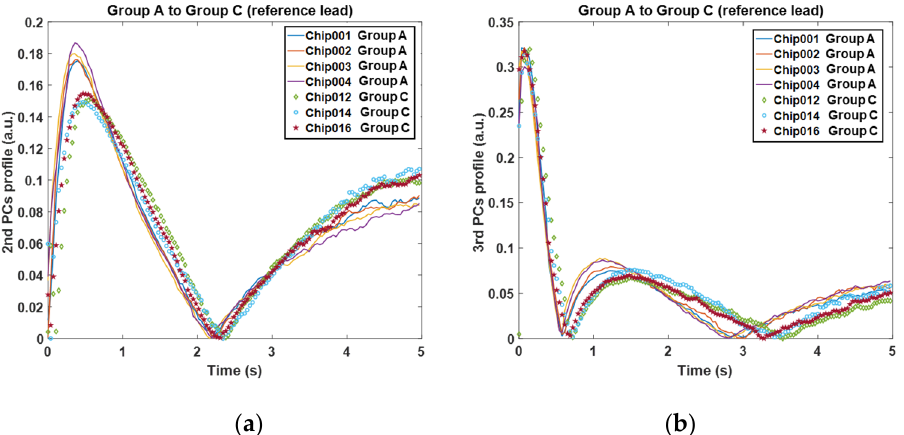
Figure 12. Feature results of the 1st verification comparison; ( a ) the 2nd principal component profiles; ( b ) the 3rd principal component profiles.